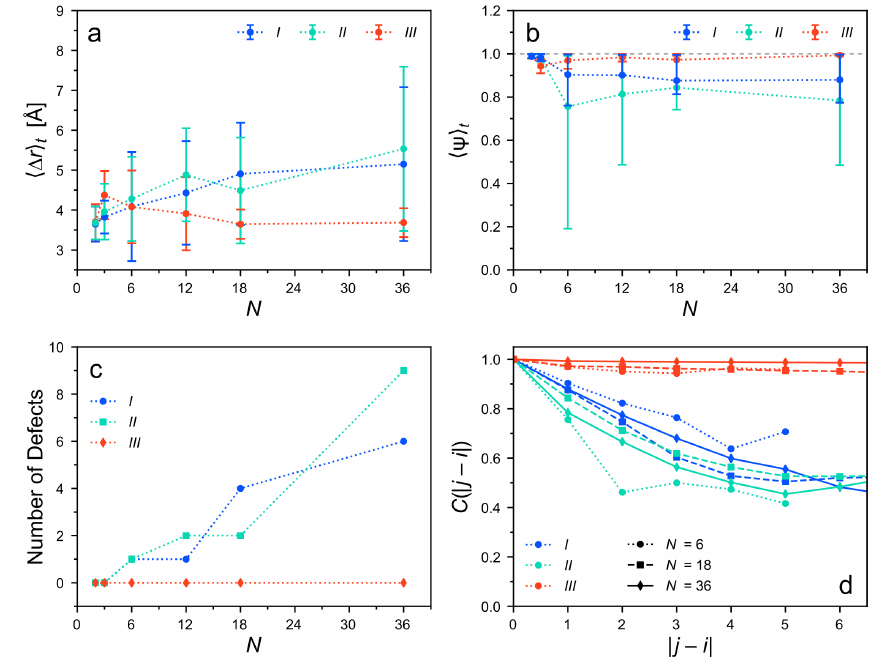
Figure 7. Structural properties of the different cluster types as a function of the cluster size. ( a ) Av- erage pairwise distance and ( b ) average columnar orientation order parameter. The error bars in ( a ) denote the standard deviation and in ( b ) delimit 68% confidence intervals. ( c ) Number of defects in the clusters. ( d ) Correlation function of the orientation unit vectors (cid:126) u i and (cid:126) u j as a function of the monomer separation | j − i | along the stack [65]. The different cluster types are distinguished by colors. Dotted lines serve as a guide to the